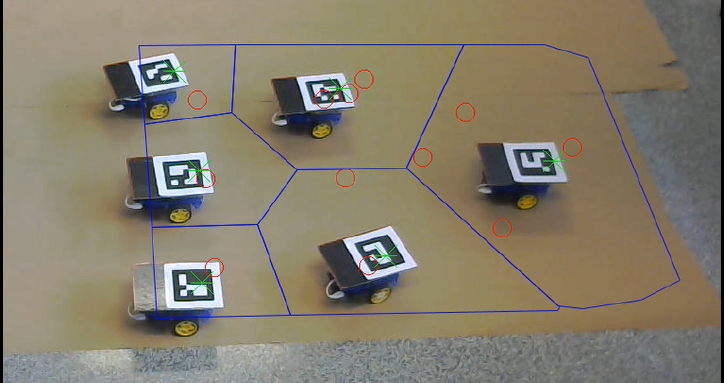
Figure 20. Setup configuration in a certain step of the experiment.